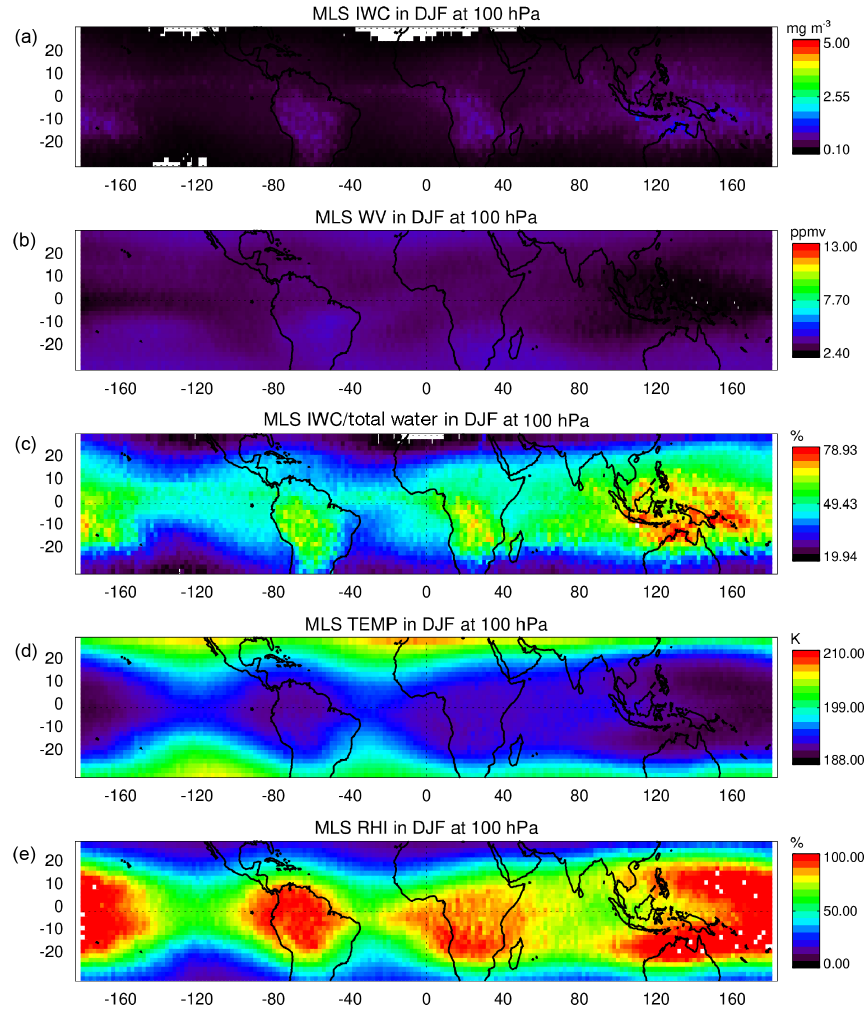
Figure 3. (a) Daily averaged ( ( day + night )/ 2) ice water content (IWC), (b) water vapour (WV), (c) IWC fraction (IWC / P W ), (d) tem- perature, and (e) relative humidity with respect to ice (RHI) in the tropopause layer (100hPa) measured by the MLS over the tropics in DJF over the period